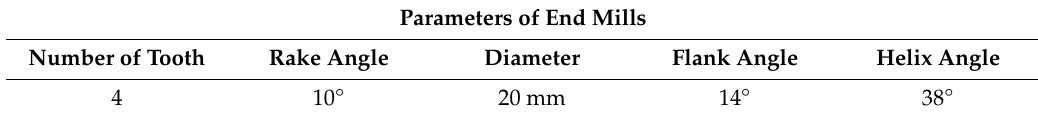
Table 1. Tool parameters for experiment [34].